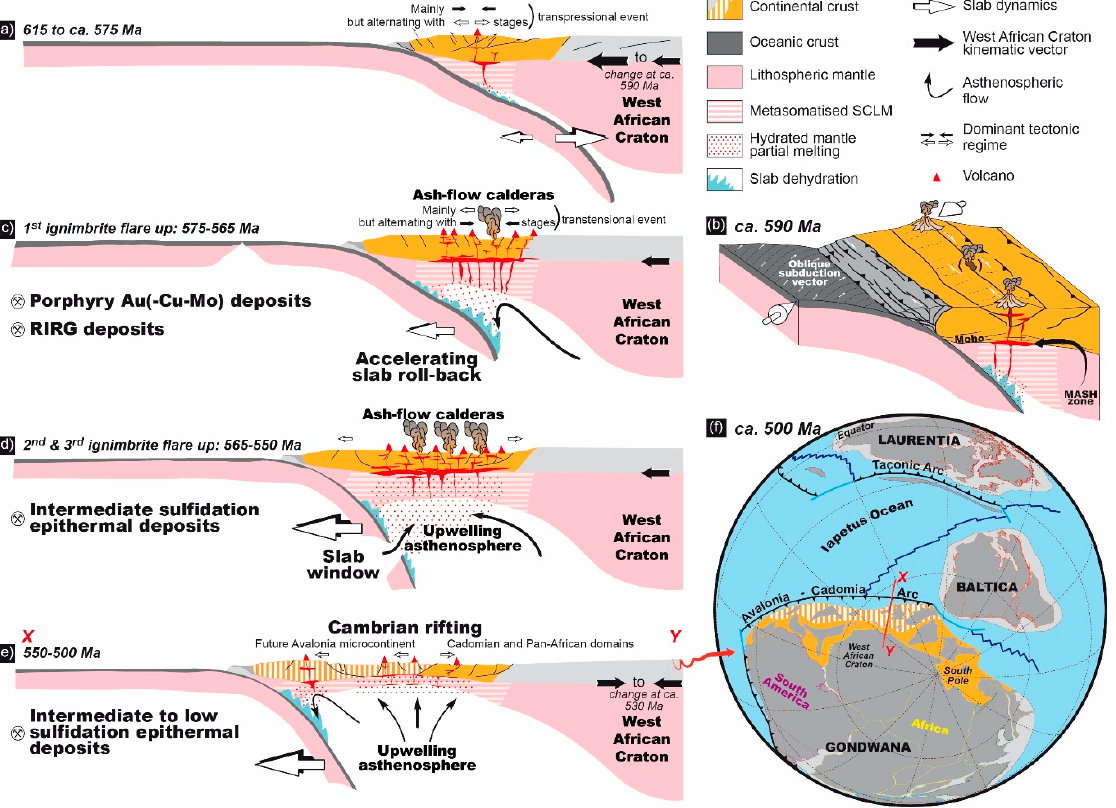
Figure 13. Compiled lithospheric-scale reconstructions ( a – e ) of the Pan-African/Cadomian belt systems from the West African Craton foreland to the Iapetus oceanic domain showing the possible progressive slab retreat since ca. 575 Ma to 500 Ma as suggested in text. Zones of partial melting in both the subcontinental lithospheric mantle (SCLM) and the lower crust, as well as the zones of storage and transfer of melts are shown in red. Kinematic vectors related to the West African Craton drifting are from Merdith et al. [204] using the GPlates software [205]. The palaeotectonic map reconstruction of Gondwana ( f ) has been realised using the GPlates software and the global plate models with kinematic continuity of Domeier [206].